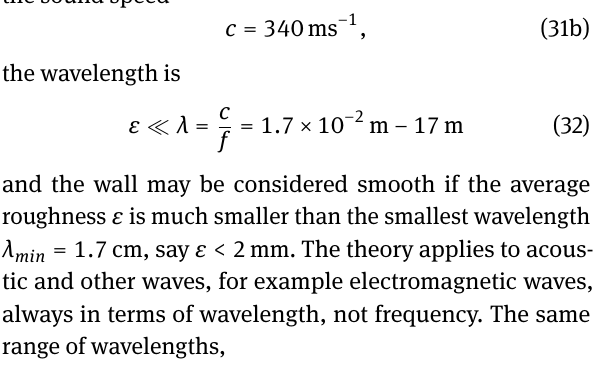
in Figure 11) than the points for greater phase values.